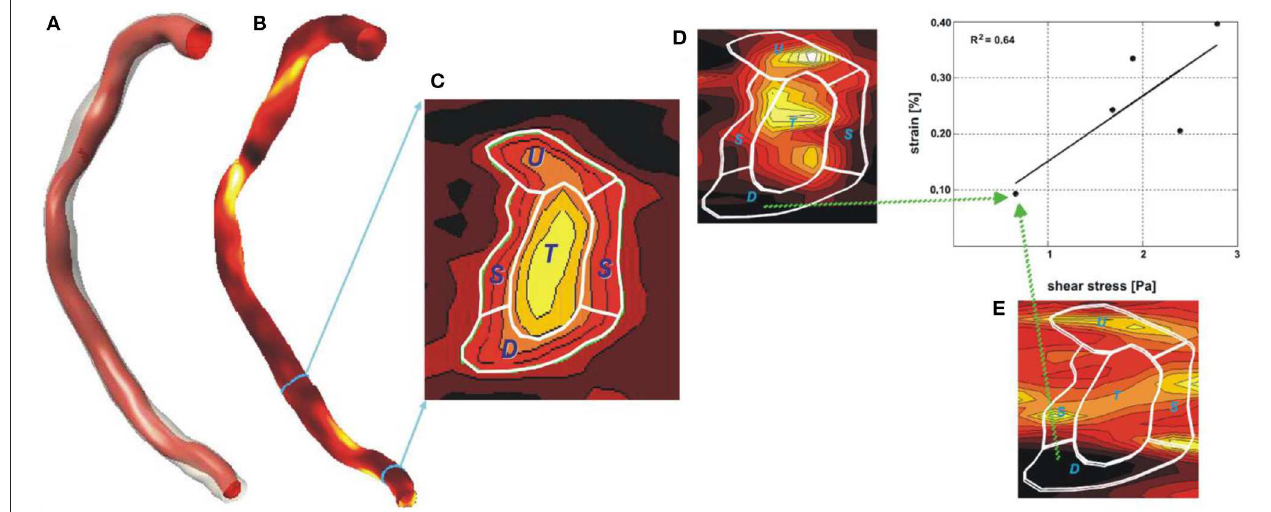
FIGURE 3 | Reconstruction of a right coronary artery from IVUS and angiographic data with the lumen surface portrayed in a red color and the outer vessel wall in a semi-transparent fashion (A) . In (B) the plaque distribution is displayed in a color-coded map (the red-brown color corresponds to low plaque thickness and yellow to increased plaque). (C) shows the distribution of the plaque in a stenotic segment in 2D. The symbols U, L, D, and T denote the upstream the lateral, the downstream shoulder and the throat of the plaque, respectively. (D) illustrates in 2D the plaque strain distribution and (E) the ESS distribution. It is obvious that there is a good correlation between vessel wall strain and ESS implying an interaction between these two variables. Image obtained with permission and modified from Gijsen et al. (